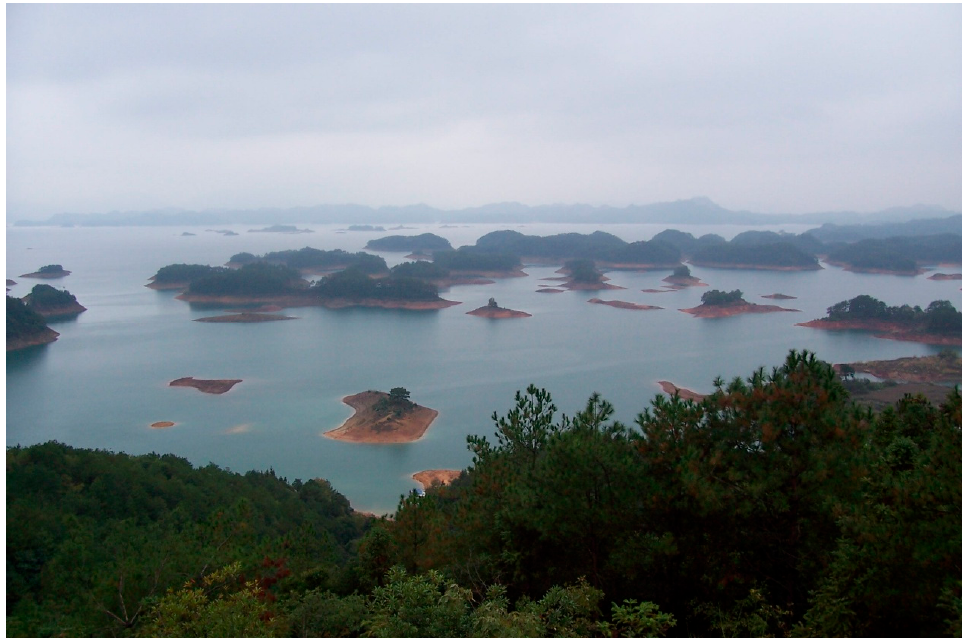
Figure 2. Map indicating the locations of the six Pistacia chinensis populations. Large island habitats B1 and B2; and small island habitats C1 and C2.